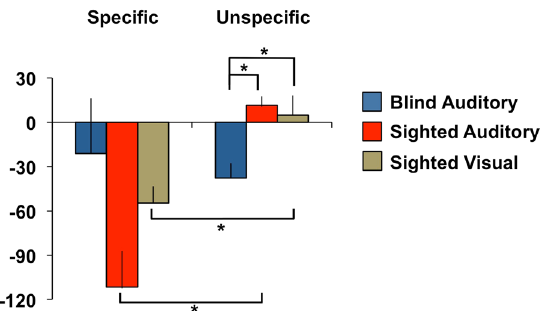
Figure 2. Absolute time difference in milliseconds for specific ( S10 – R4 ) and unspecific ( R4 – R2 ) learning. The error bars show standard error of the mean. * p <